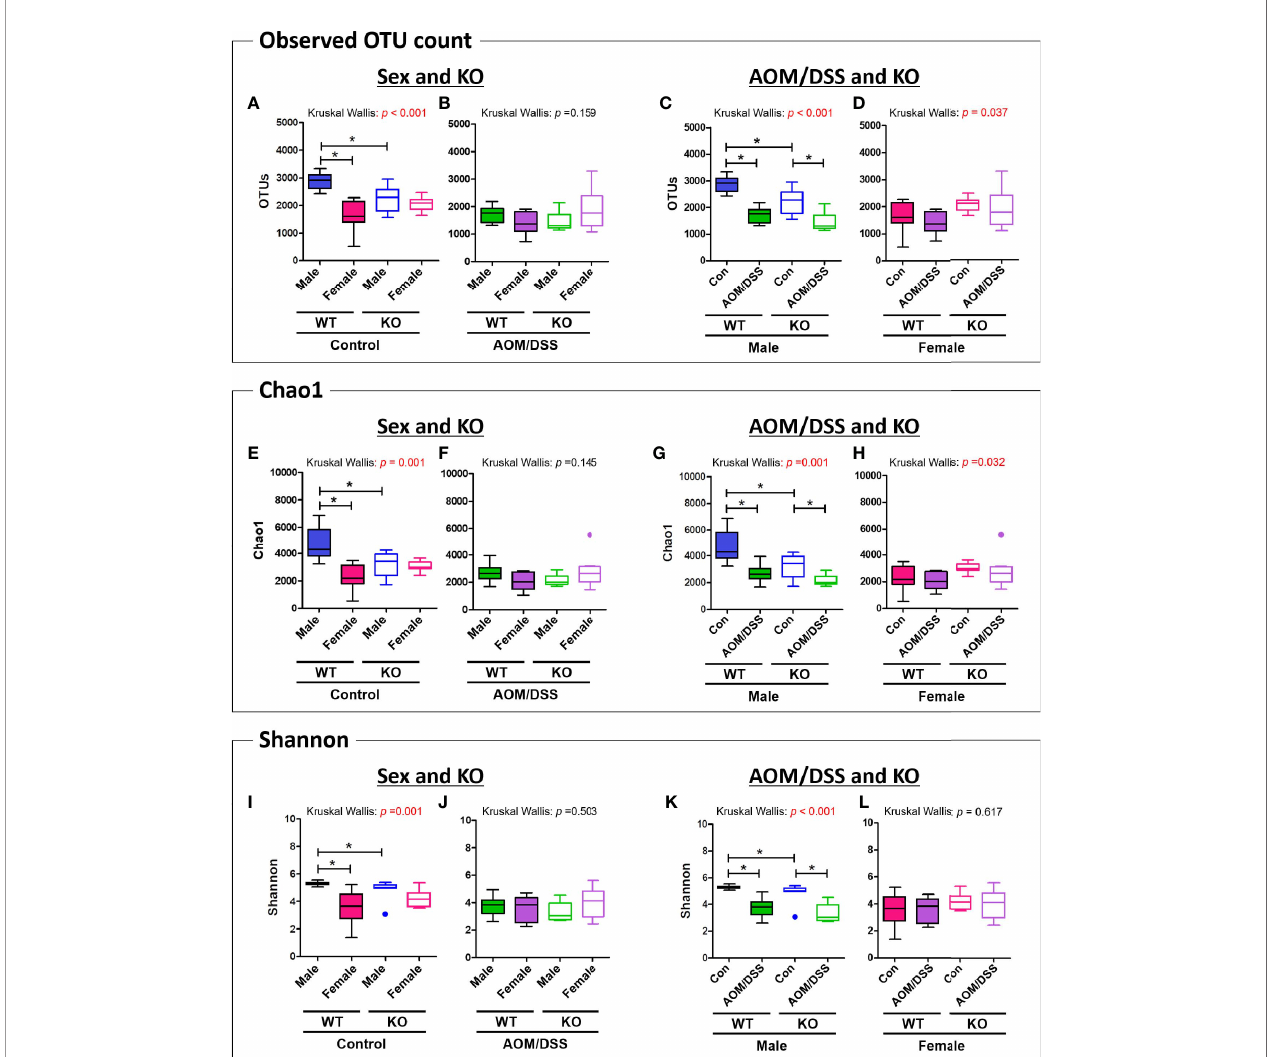
FIGURE 3 | Analysis of species richness and diversity of the gut microbiome. (A – D) Observed OTU count, (E – H) species richness (Chao1 index), and (I – L) alpha diversity (Shannon index) of the microbial community in the groups with “ Sex and KO ” criteria (A, B, E, F, I, J) , as well as with AOM/DSS and KO criteria (C, D, G, H, K, L) . Data are expressed as the mean ± SEM. Whiskers show the minimum and maximum values. The p -values obtained from the Kruskal – Wallis test is shown in the fi gure; * p < 0.05 for comparison between two groups (Mann – Whitney U-test). OTU, operational taxonomic unit; WT, wild-type; Nrf2 KO, Nrf2 knockout; Con, control; AOM, azoxymethane; DSS, dextran sodium sulfate; SEM, standard error of